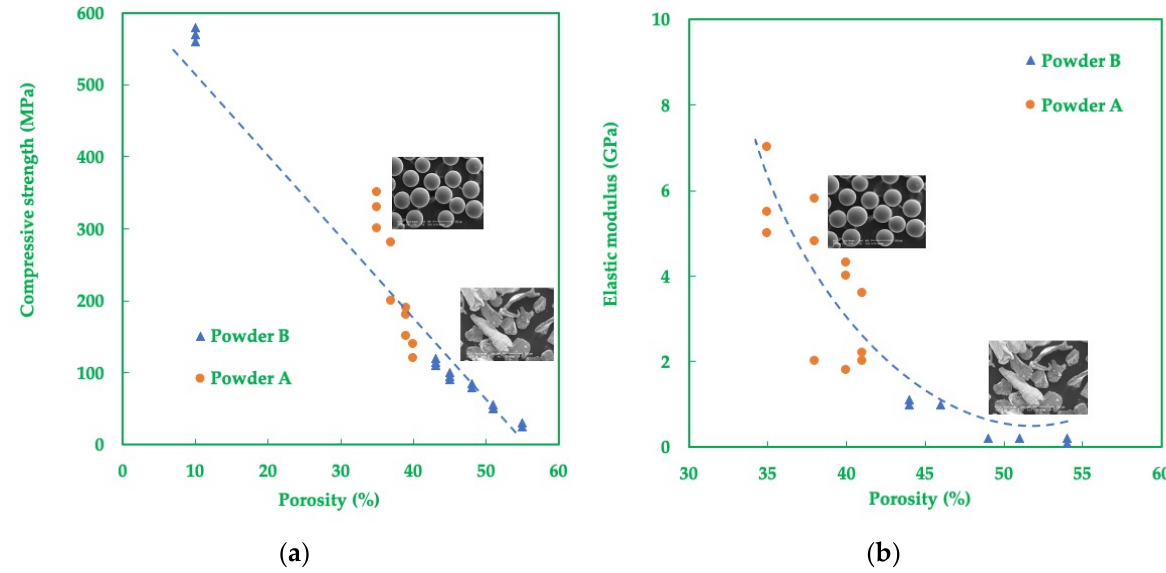
Figure 25. Effect of porosity on ( a ) compressive strength and ( b ) elastic modulus for round and angular particles (modified from [297]).